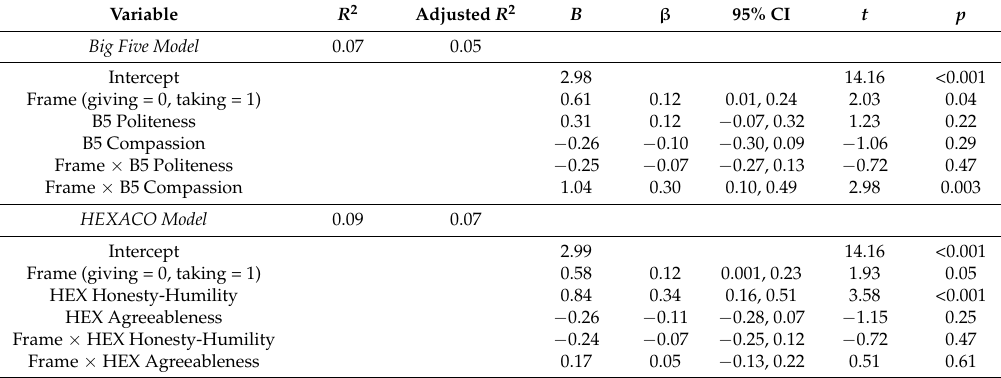
Table 2. Regression analysis of prosocial personality traits on the amount allocated to the partner in giving and taking dictator